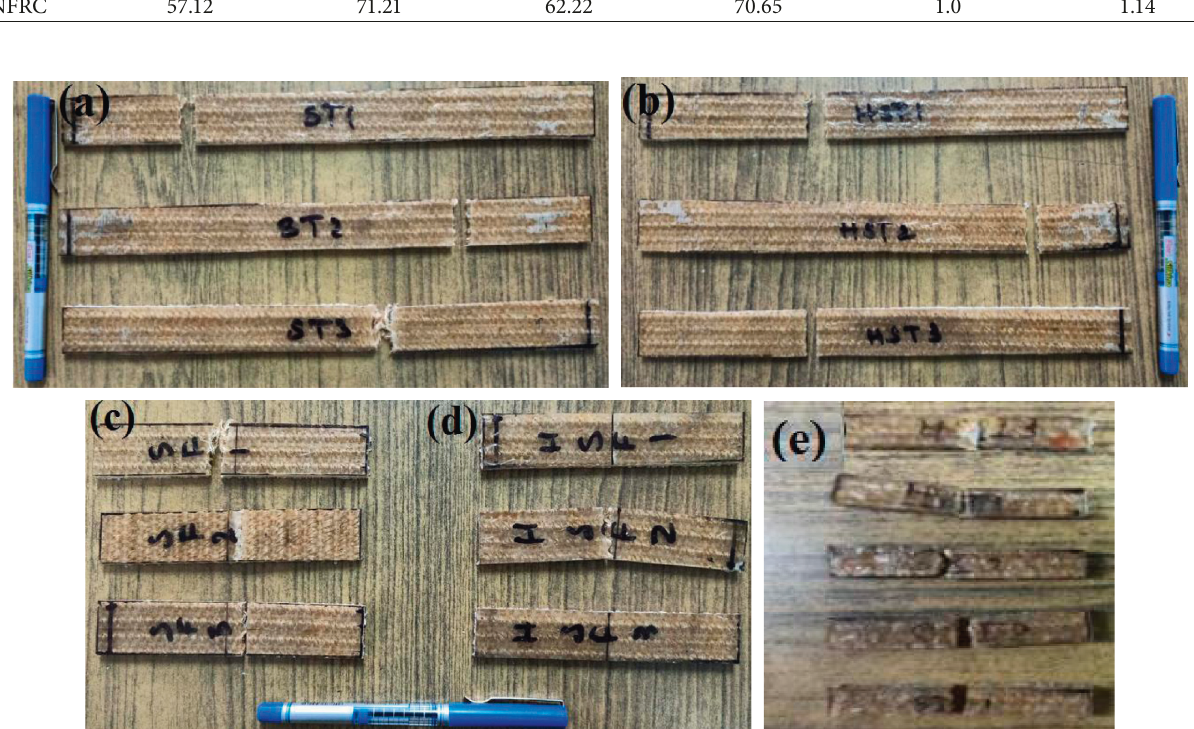
Figure 9: Sisal fabric-reinforced composites. (a) Untreated-fractured tensile specimens. (b) Heat-treated-fractured tensile specimens. (c) Untreated-fractured flexure specimens. (d) Heat-treated-fractured specimens undergo flexural failure. (e) Impact test fractured specimens.